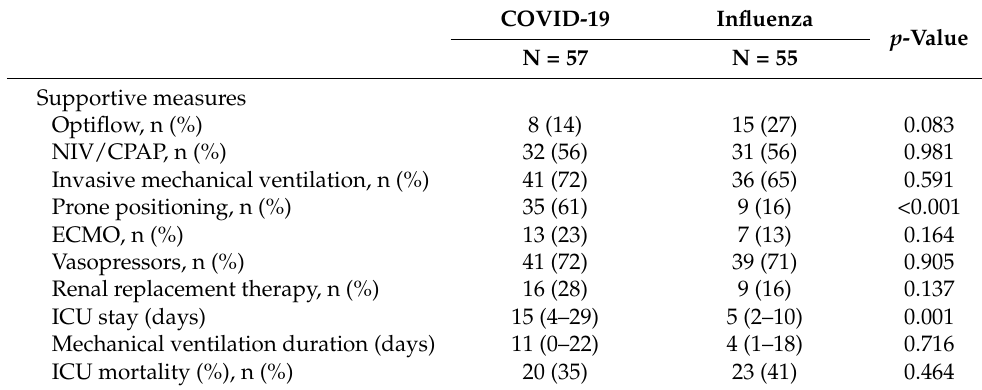
Table 6. ICU Patient outcome.